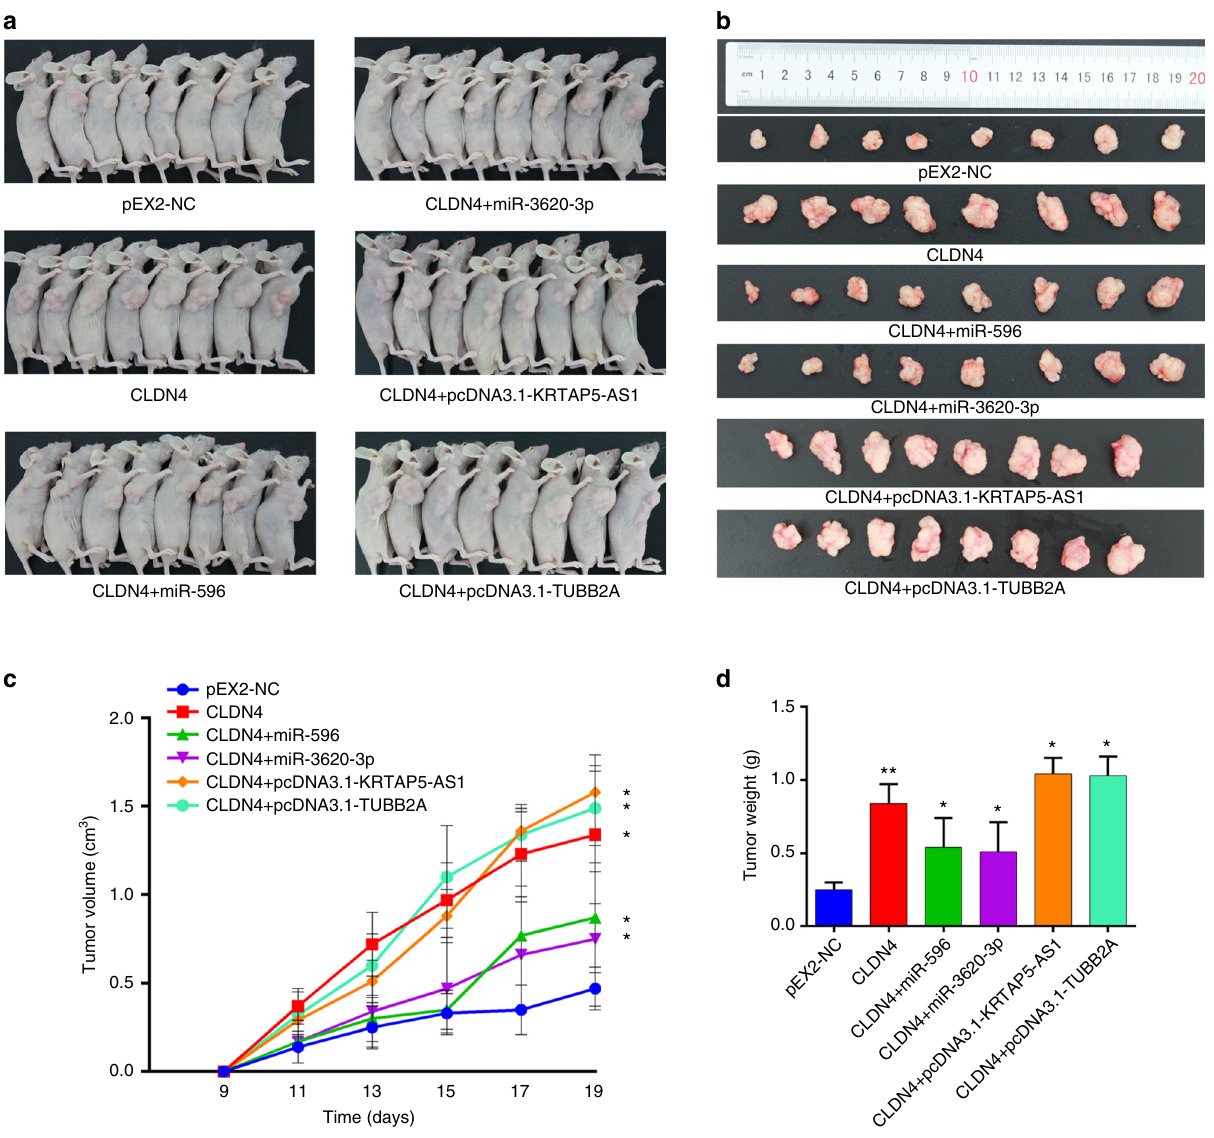
Fig. 7 CLDN4 promotes proliferation in vivo. a In vivo tumor lumps of xenograft mouse models composed of CLDN4 overexpressing cells, which were treated with miR-596 or miR-3620-3p as well as pcDNA3.1-KRTAP5-AS1 or pcDNA3.1-TUBB2A. Mice were sacri fi ced at the 19th day after injection and each tumor lump was removed from the body. b Images of the tumor lumps of each group at the endpoint of the experiment described in a . c The tumor growth curves of in vivo tumor volumes. Data are mean ± s.d. of the tumor volumes, n = 8, * P < 0.05. d The mean tumor weight of each group. Data are shown as mean ± s.d. of the tumor weights, n = 8. The data statistical signi fi cance is assessed by Student ’ s t-test. * P < 0.05, ** P <